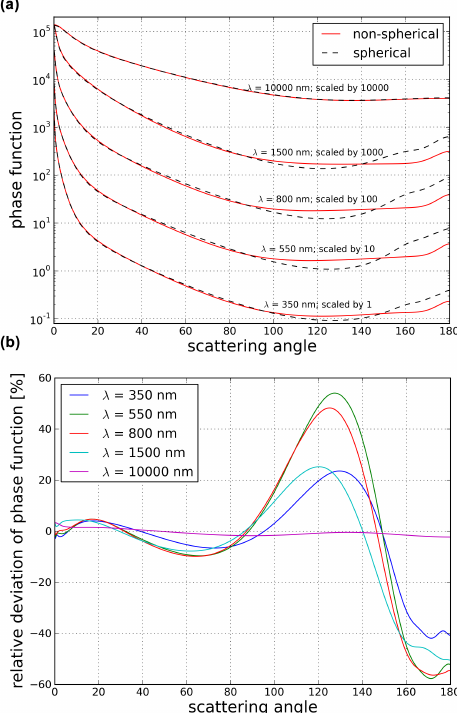
Figure 2. (a) Phase functions of desert aerosol for different wave- lengths, assuming spherical and spheroidal mineral particles with a size- dependent aspect ratio distribution after Kandler C. For details see text. The scale of the phase functions for the different wave- lengths is shifted by a factor 10 in each case. (b) Relative devia- tions (%) of phase functions assuming spheroidal mineral particles from phase functions of spherical particles, for desert aerosol and the conditions shown in (a)